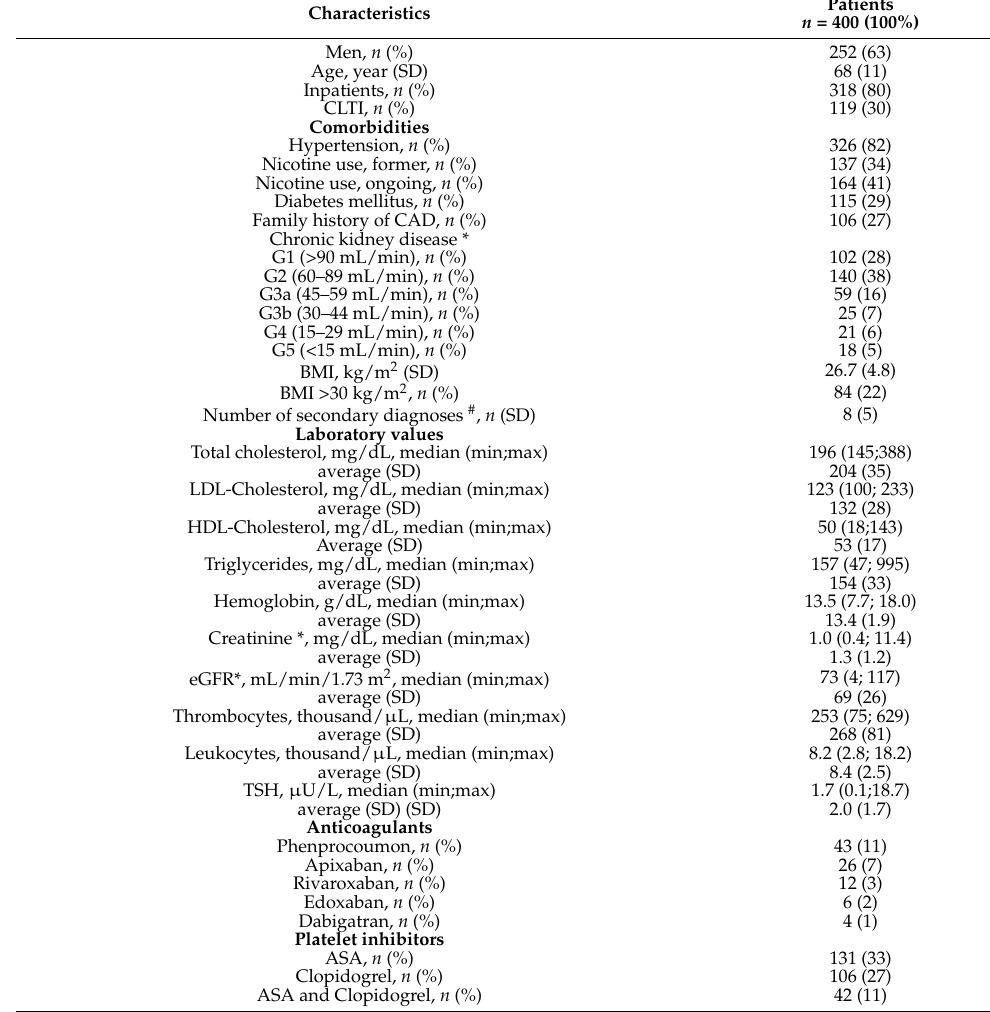
Table 1. Baseline characteristics of the study